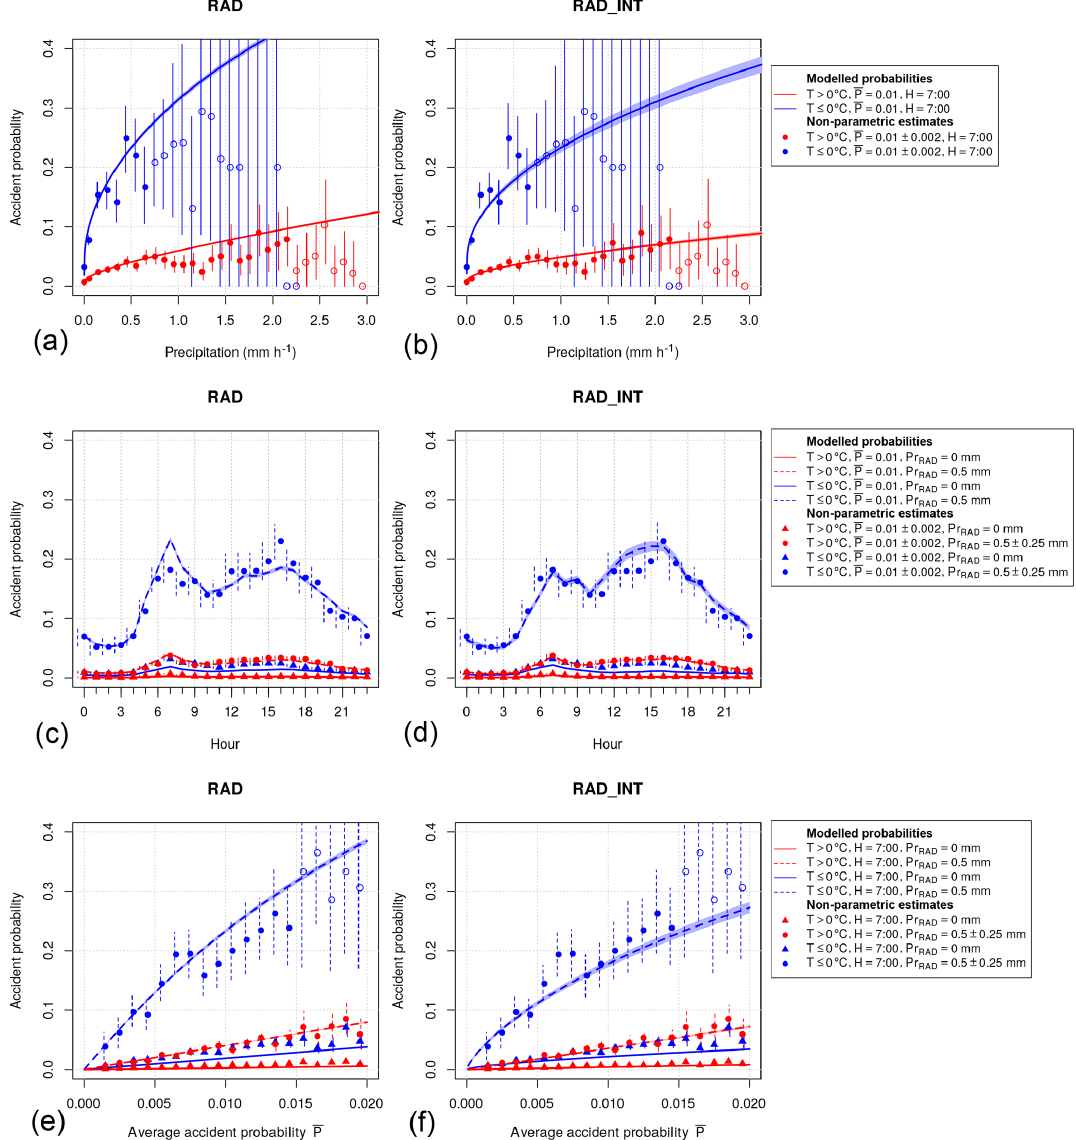
Figure 2. Comparison of modeled probabilities of weather-related road accidents with nonparametric probability estimates. Probabilities (lines) and 95% confidence intervals based on standard errors (shading) of the model RAD (a, c, e) and RAD_INT (b, d, f) are displayed as a function of hourly precipitation (a, b) , hour of the day (c, d) and the temporal average accident probability of the administrative district (e, f) for different parameter settings (see legends for details). Nonparametric estimates of probabilities (markers) and 95% confidence intervals based on bootstrapping (vertical lines) are shown for corresponding parameter